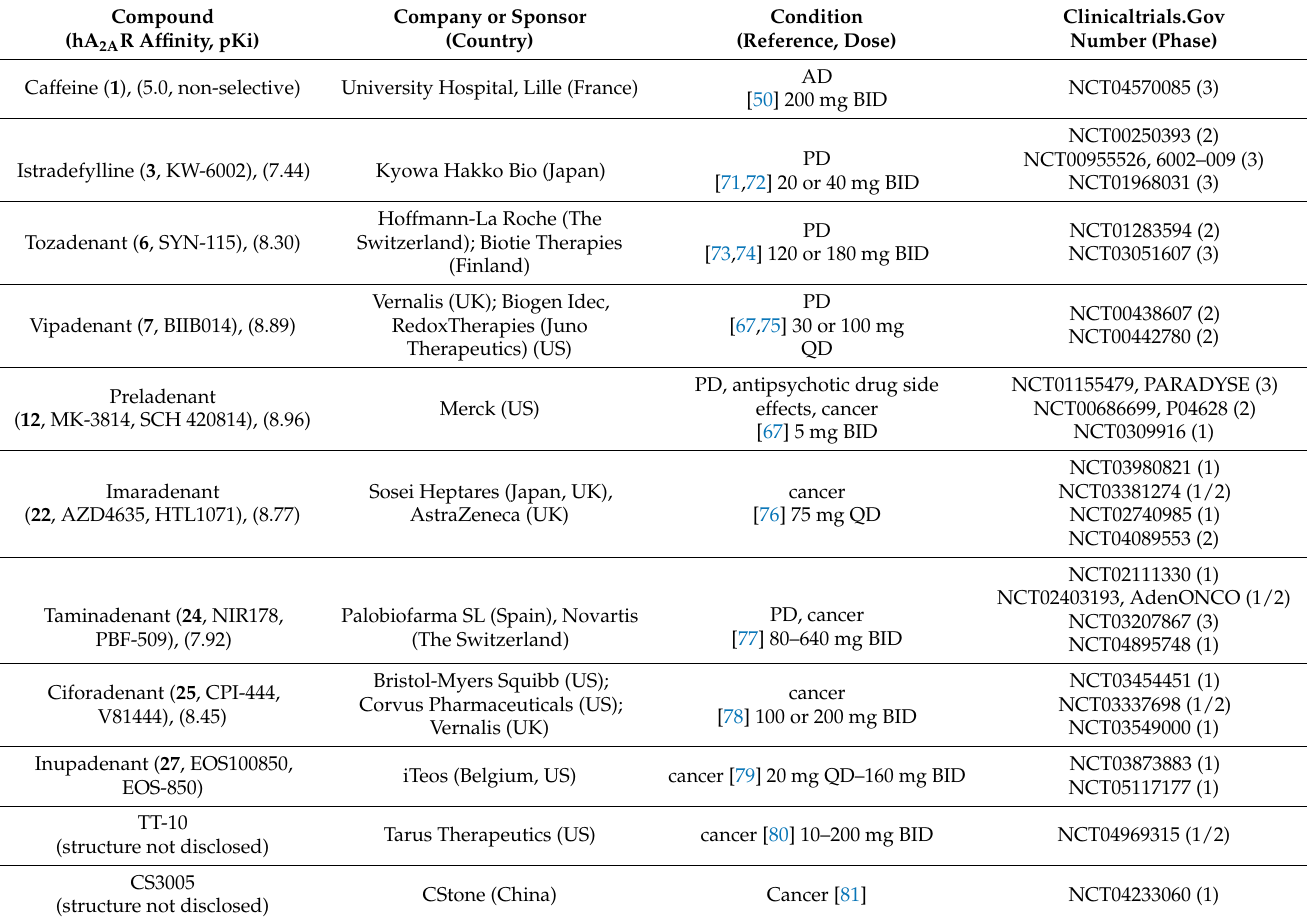
Table 1. A 2A receptor antagonists that are or have been in clinical trials for neurodegenerative diseases and/or for cancer immunotherapy. This list does not include compounds that display mixed selectivity for A 2A and A 2B